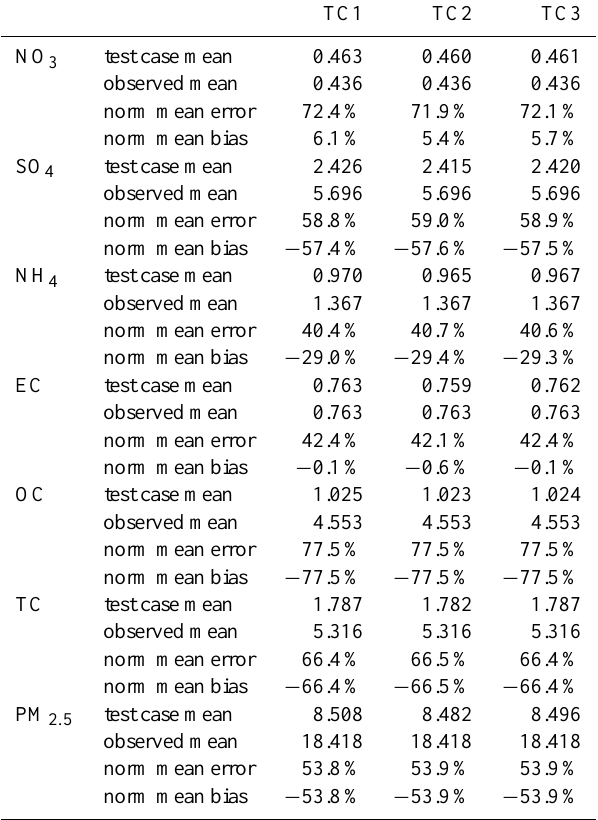
Table 3. Comparison of model results (inµgm − 3 ) for three test cases to observations from the Decatur monitor (#130890002) in June and July 2002. Normalized mean error and normalized mean bias are shown.